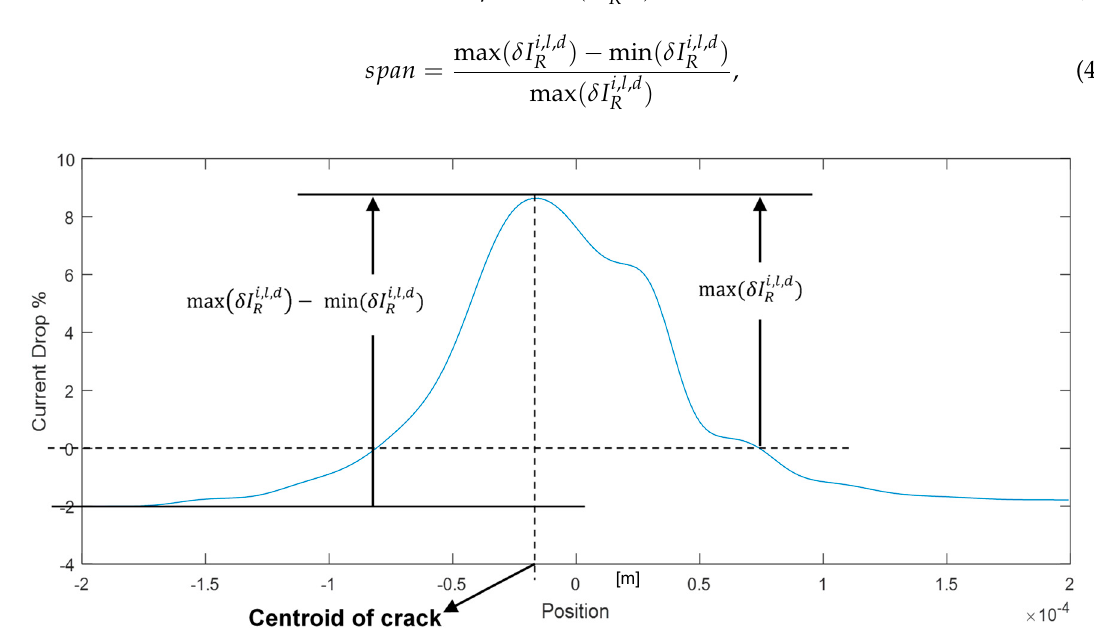
Figure 3. An example of the electrical response curve in the area around the crack.